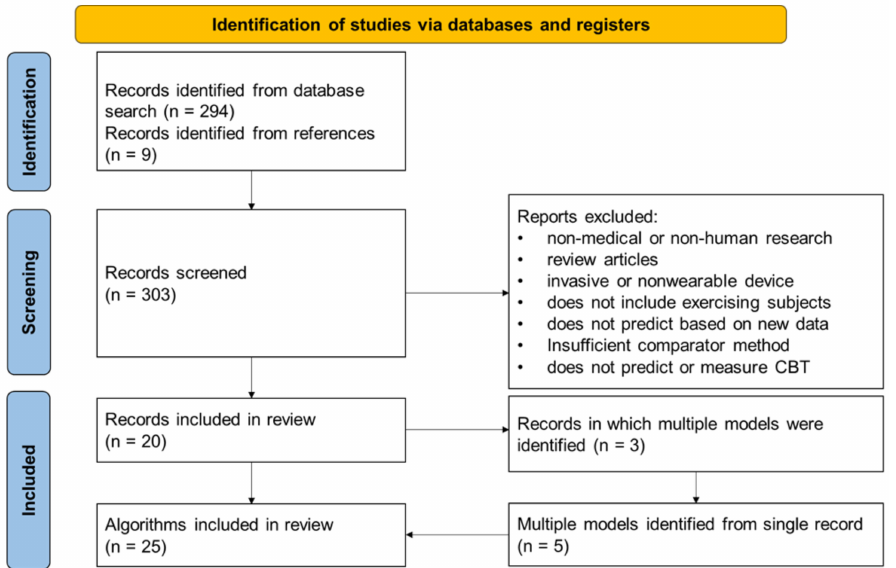
Figure 3. Flowchart depicting the search results and methodology of the study selection. Additionally depicted is the enumeration of multiple prediction models from some